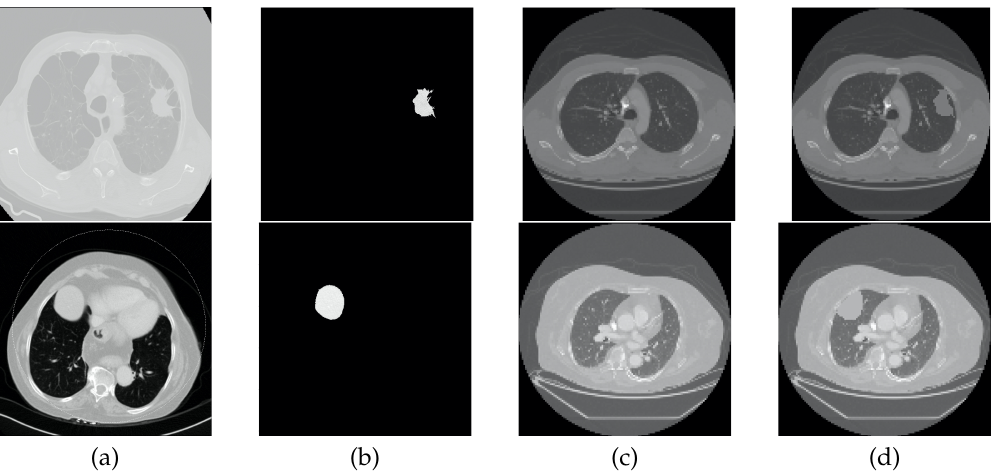
Figure 3. Example of data augmentation. From left to right: ( a ) original CT image containing a nodule; ( b ) ROI of the nodule; ( c ) original CT image without nodules; ( d ) and synthetic CT image that includes a